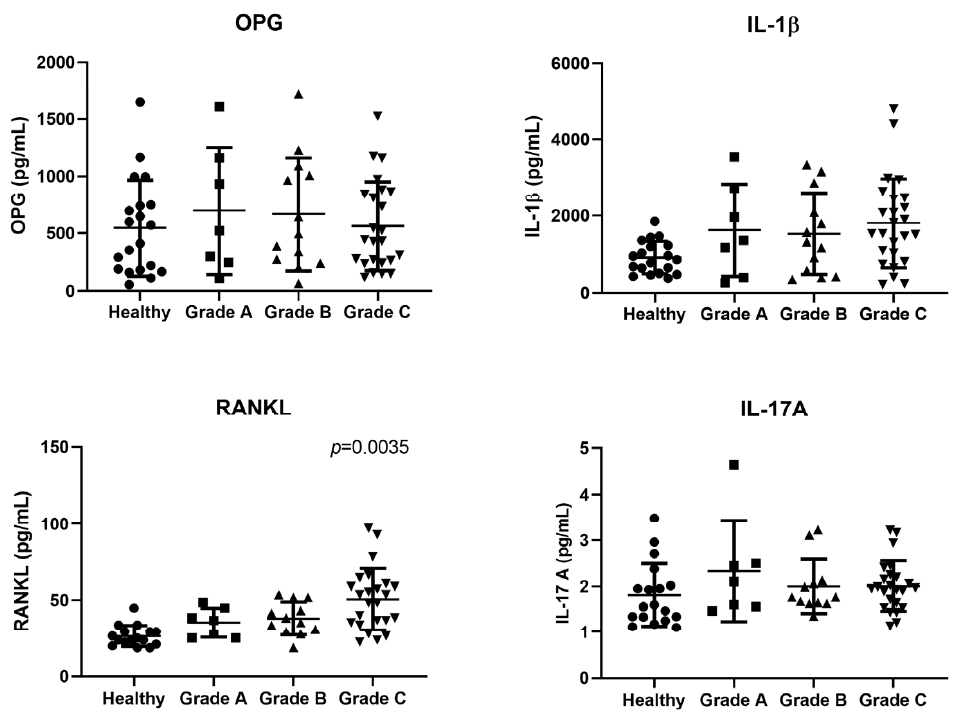
Figure 1. Scatter plots of IL-1 β , OPG, IL17-A and RANK-L salivary levels (pg/mL) in the different grade groups. OPG: osteoprotegerin: IL-1 β : interleukin -1 β ; RANK-L: receptor activator of nuclear factor kappa-B ligand; IL-17A: inteleukin- 17A; RANK-L/OPG: RANKL/OPG ratio; Horizontal lines represent M(SD) = mean (standard deviation). Statistical analysis with p value derived from the ANOVA one-way test and Bonferroni test ( p = 0.035).